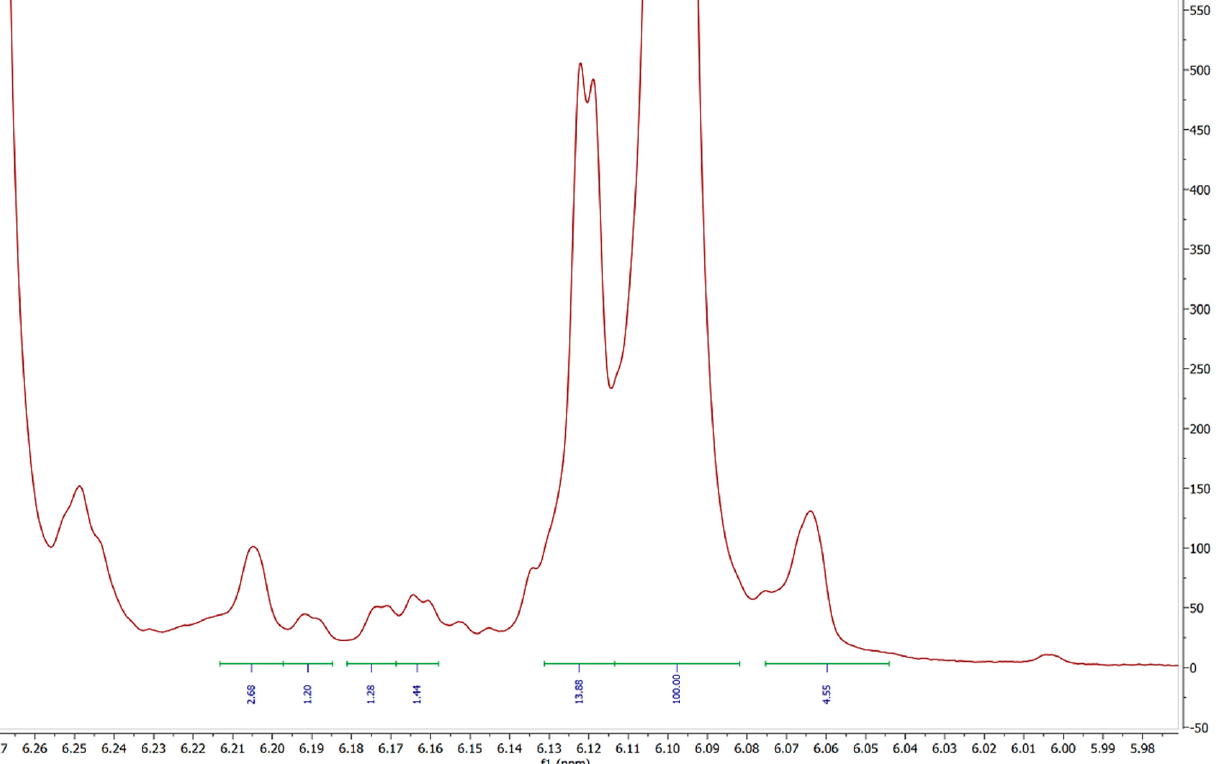
Figure 6. Certificate of Analysis chromatogram of sample 6. Mass spectrometry and MS 2 analysis of peaks in sample 4 revealed several impurity peaks. Figure 8 is the total ion chromatogram for sample 4 over the mass range of 317–750 Da. Table 2 is a summary of the LC/MS experiment. The peak number in the first table column correspond to the numbers shown in Figure 8. The second column indicates the retention time of the peak. The “major peak” column indicates the mass of the base peak observed for each chromatographic peak. The last column shows the masses of other peaks observed in the mass spectrometry scan.